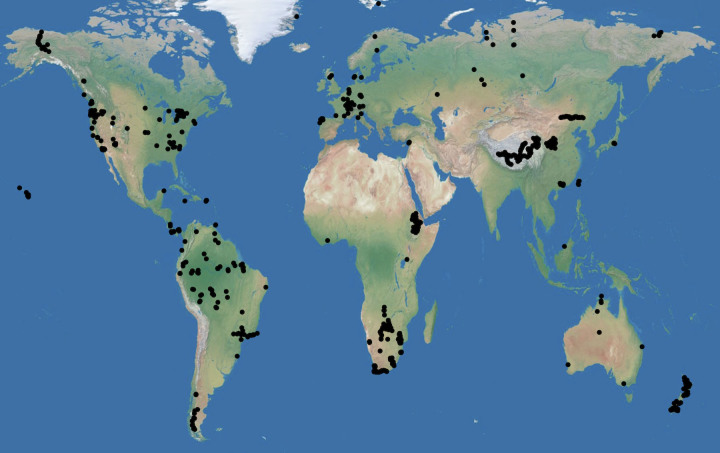
Map of sites used in this study.Map created in JMP 10.0.2.